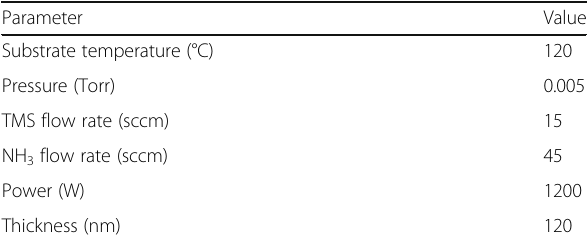
Table 2 Deposition parameters of the SiN x layer